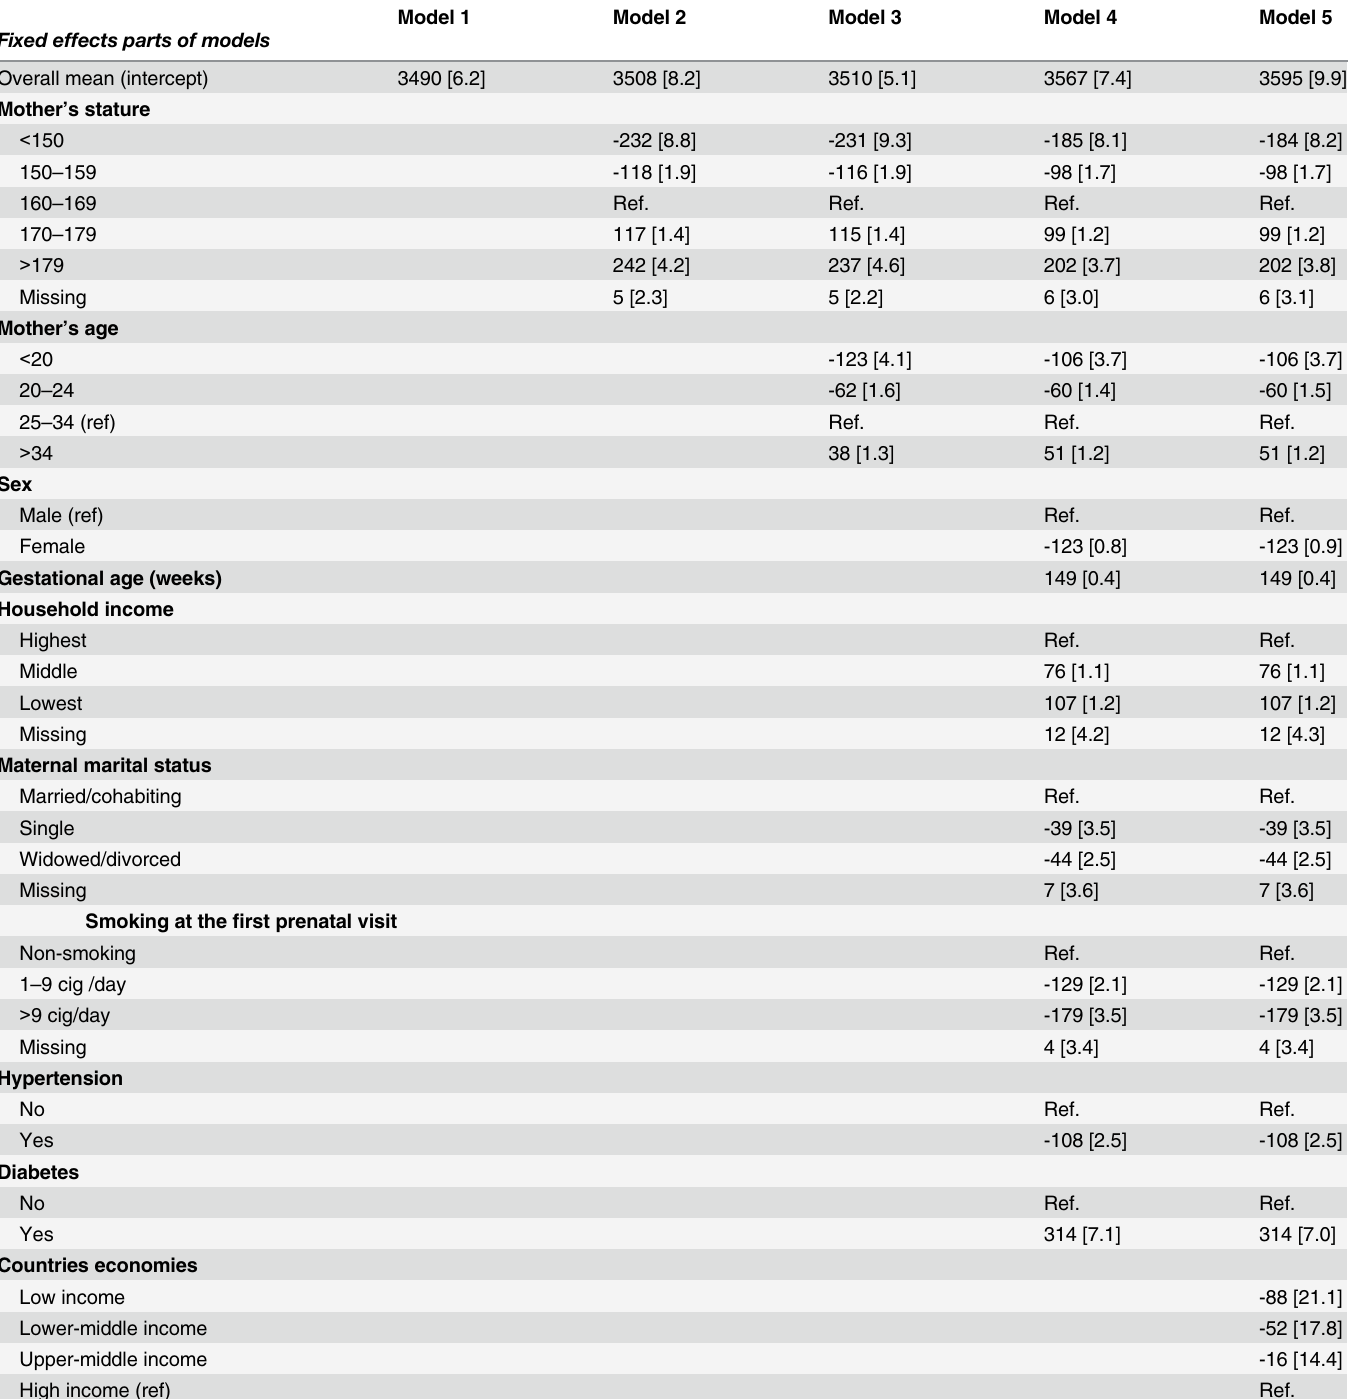
Table 2. Multilevel linear regression analysis of babies, mothers and maternal countries of birth, modelling birthweight (in grams) 1